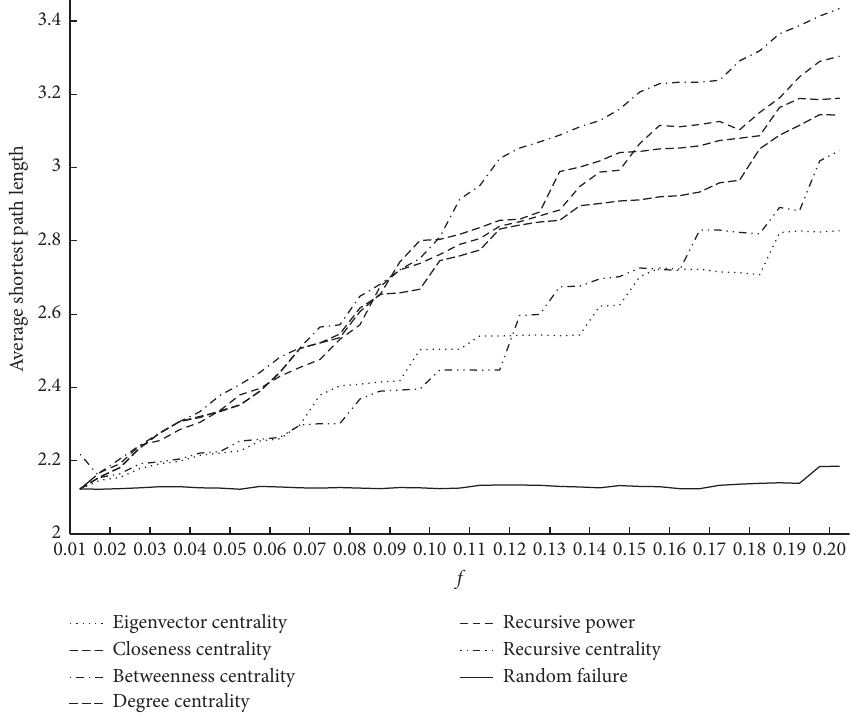
Figure 6: Evolution of the average shortest path length in unweighted and weighted